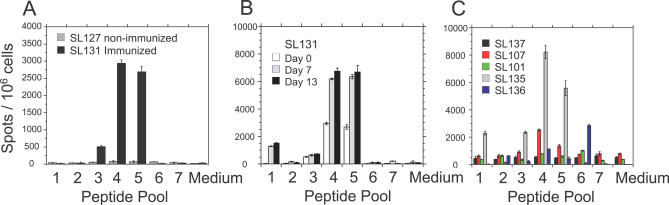
TCLs Raised from Vaccinia Immune Donors Recognize Pools of Predicted HLA-DR1-Binding Peptides(A) IFN-γ ELISPOT response of vaccinia-specific TCLs from DR1+ donors to pools of predicted peptides. TCL were generated from PBMCs obtained from a non-immunized (gray bars) or immunized (dark bars) DR1+ donor by stimulation with a crude preparation of heat-inactivated vaccinia virus. After 15 to 20 d of in vitro expansion, cells were tested in an IFN-γ ELISPOT assay using autologous PBMCs as APCs and the peptide pools as antigen. T cell assays were performed in cRPMI+10% human serum (see Materials and Methods).(B) Kinetics of the IFN-γ ELISPOT response in the immunized DR1 donor after a boosting immunization: shown are the T cell responses to the peptide pools for TCLs generated from blood samples obtained at the indicated time points.(C) Recognition of peptide pools by TCLs generated from PBMCs obtained from five non-DR1 donors: three immunized (SL101, SL107, and SL135), one accidentally infected with the vaccinia virus WR strain (SL136), and one non-immunized (LS 137).